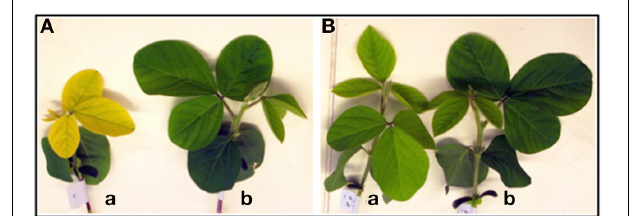
FIGURE 2 | Fourteen-day-old shoots of “Fe-efficient” (EF) accession (PI 360952) grown under Fe-deficient (DEF) (a) and Fe-sufficient (SUF) (b) conditions at 60% (A) and 90% (B) relative humidity